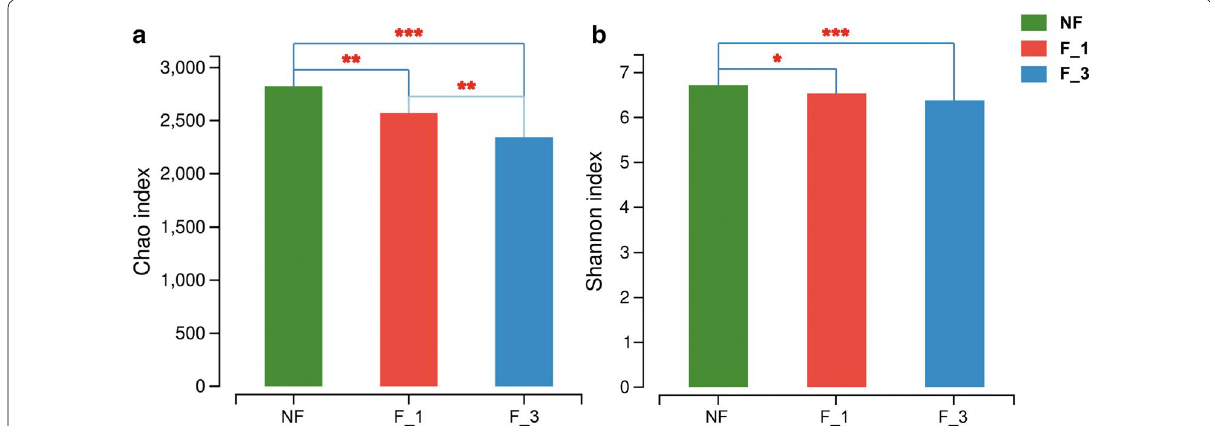
Fig. 4 Microbiota richness a and diversity b as measured by Chao and Shannon indexes observed in the different fumigation years. P values was from two-tailed Student’s t test (P < 0.05). 0.01 < P chloropicrin-fumigation for 1 year, F_3 continuous chloropicrin-fumigation for 3